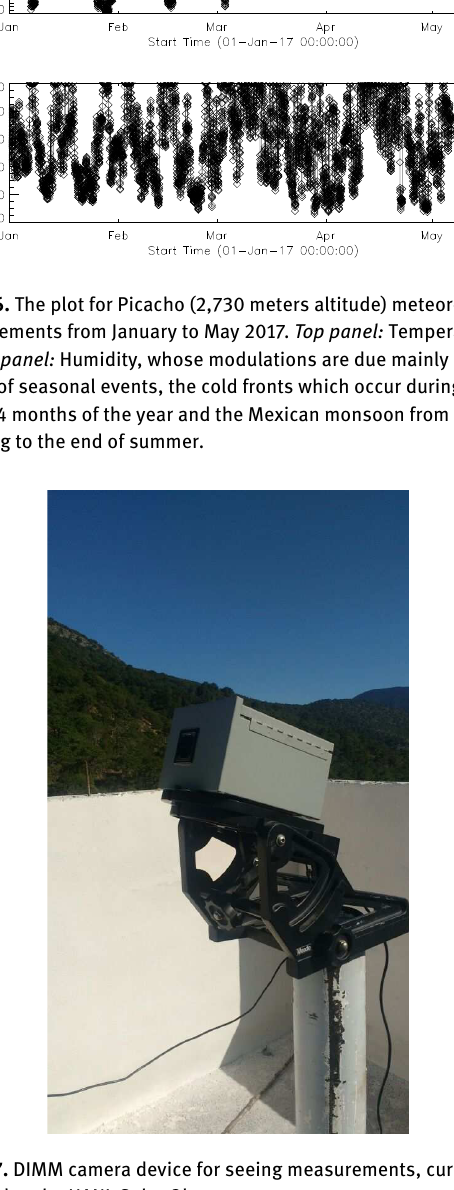
year. Such measurements will be complemented by data from clouds counting through a whole-sky camera and seeing measurements through a Differential Image Motion Monitor (DIMM) camera (see Figure 7). Both instruments are already in the testing phase at the UANL Solar Obser- vatory. This site is in enclosed circle region in Figure 10 as